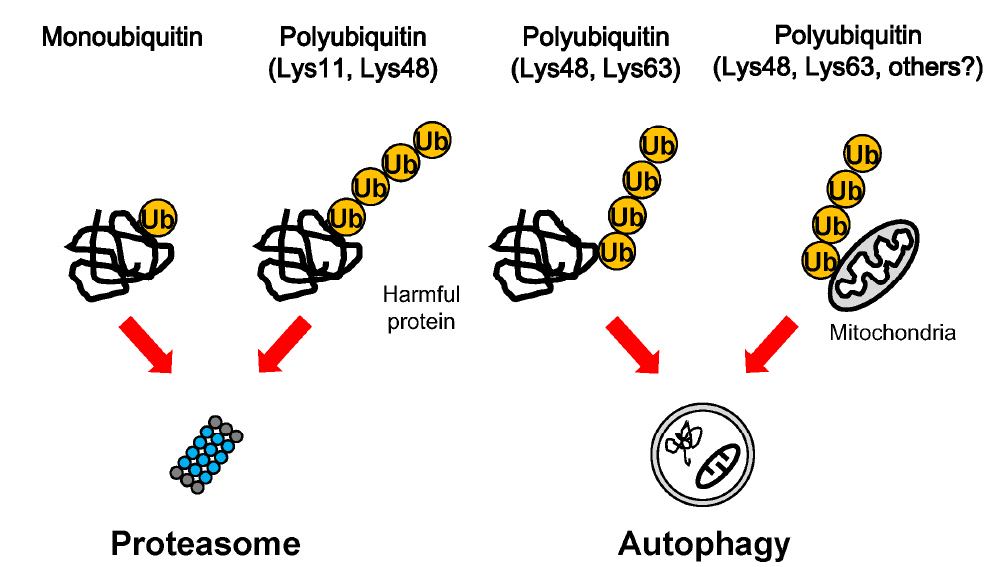
Figure 1. Degradation of ubiquitinated cargoes. Harmful proteins and mitochondria can be modified by various ubiquitin additions, such as mono-ubiquitin and Lys-11-, Lys-48-, and Lys-63-poly-ubiquitin chains. The proteasome preferentially degrades mono-ubiquitinated proteins and Lys11- and Lys-48-linked proteins, whereas autophagy preferentially eliminates Lys-48-, and Lys-63- decorated protein aggregates and mitochondria.